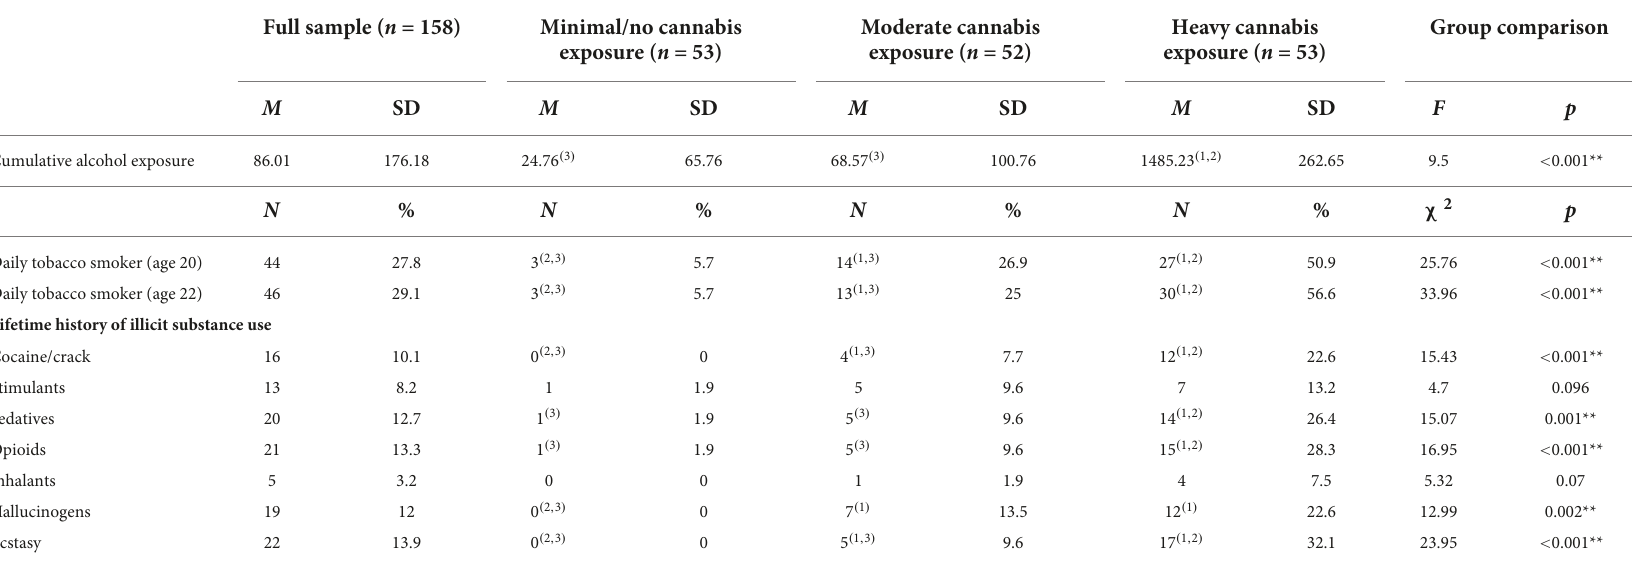
TABLE 3 Alcohol and other substance use